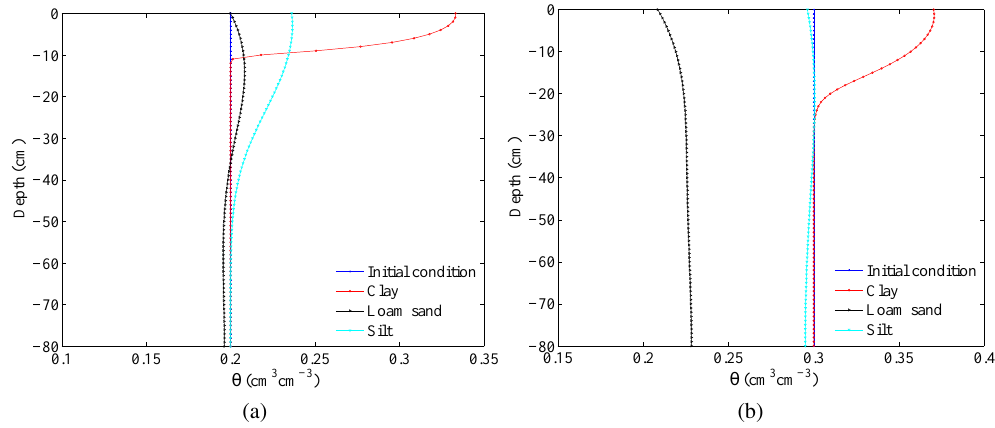
Fig. 4. Synthetic (left) and forecast (right) soil moisture profiles at initial time (0-hour) and at time that the GPR Fig. 4. Synthetic ( a ) and forecast ( b ) soil moisture profiles at initial time (0h) and at time that the GPR data assimilation begins (80h) data assimilation begins (80-hour) corresponding with the loamy sand, silt and clay soil types. corresponding with the loamy sand, silt and clay soil